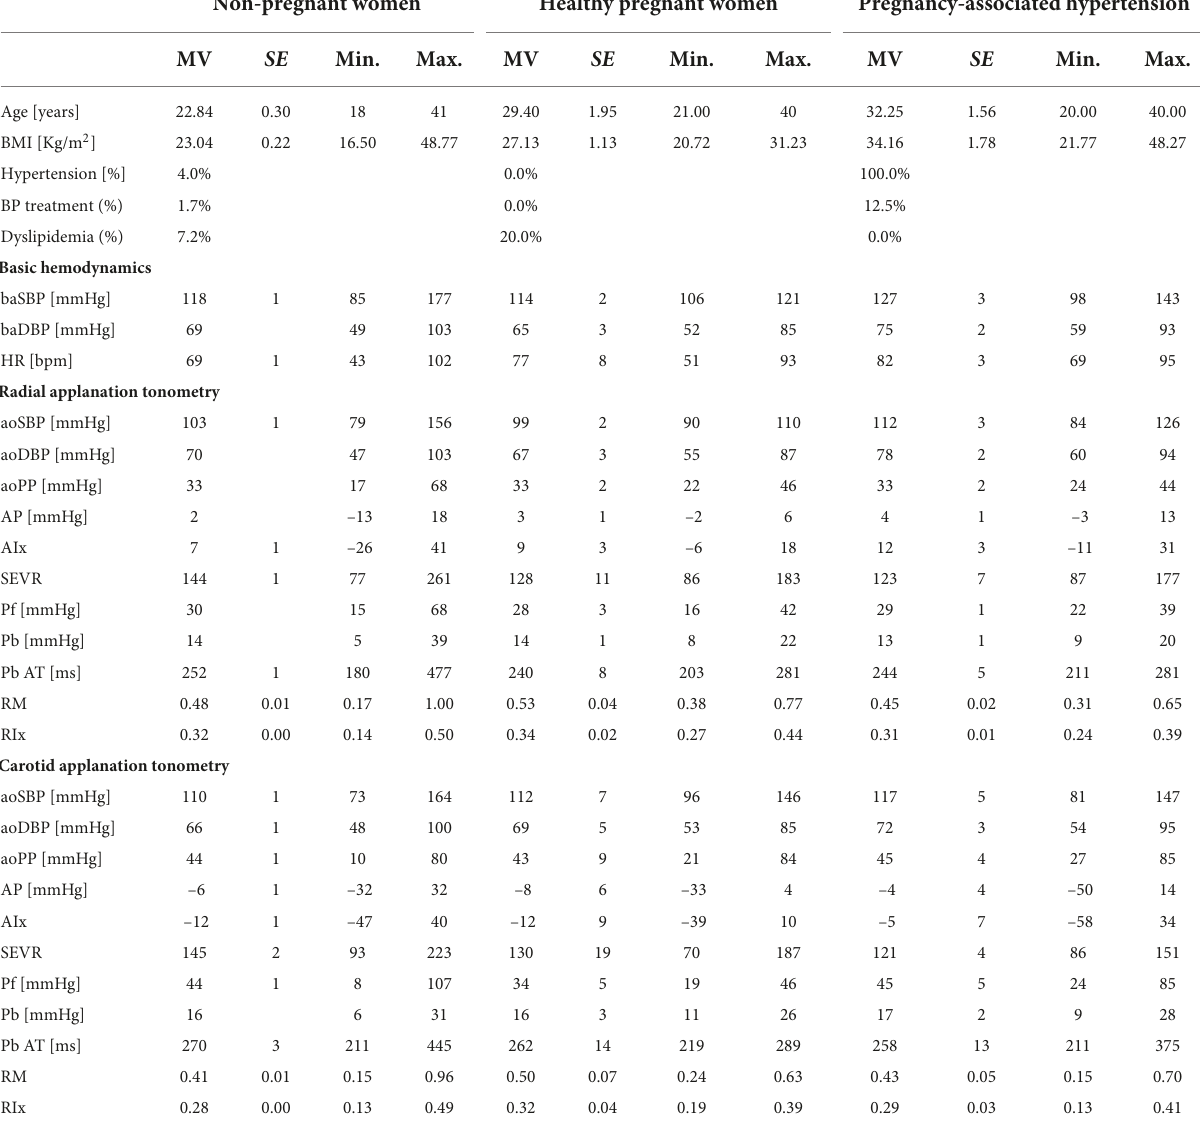
TABLE 1 Clinical and blood pressure levels and waveform-derived indexes according to the study groups. Non-pregnant women Healthy pregnant women Pregnancy-associated hypertension MV SE Min. Max. MV SE Min. Max. MV SE Min. Max.